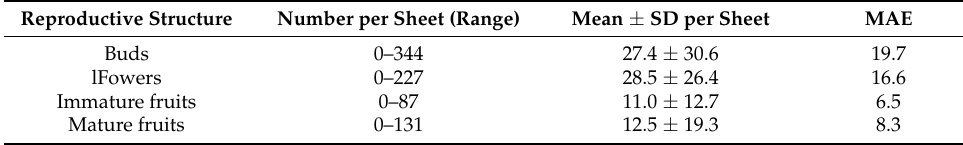
Figure 2. Box plots of counting error vs. number of reproductive units present on each herbarium specimen (as estimated manually by human observers) for ( A ) buds, ( B ) flowers, ( C ) immature fruits, and ( D ) mature fruits. The numbers below each box plot denote the number of herbarium specimens represented in each box plot. Table 1. Summary statistics showing the numbers of reproductive structures in each class present on each sheet as determined by human observers (i.e., manually-derived counts). The mean average error (MAE) was calculated and used to evaluate the performance of the machine learning model. The MAE measures the mean absolute error per class of reproductive structure across all